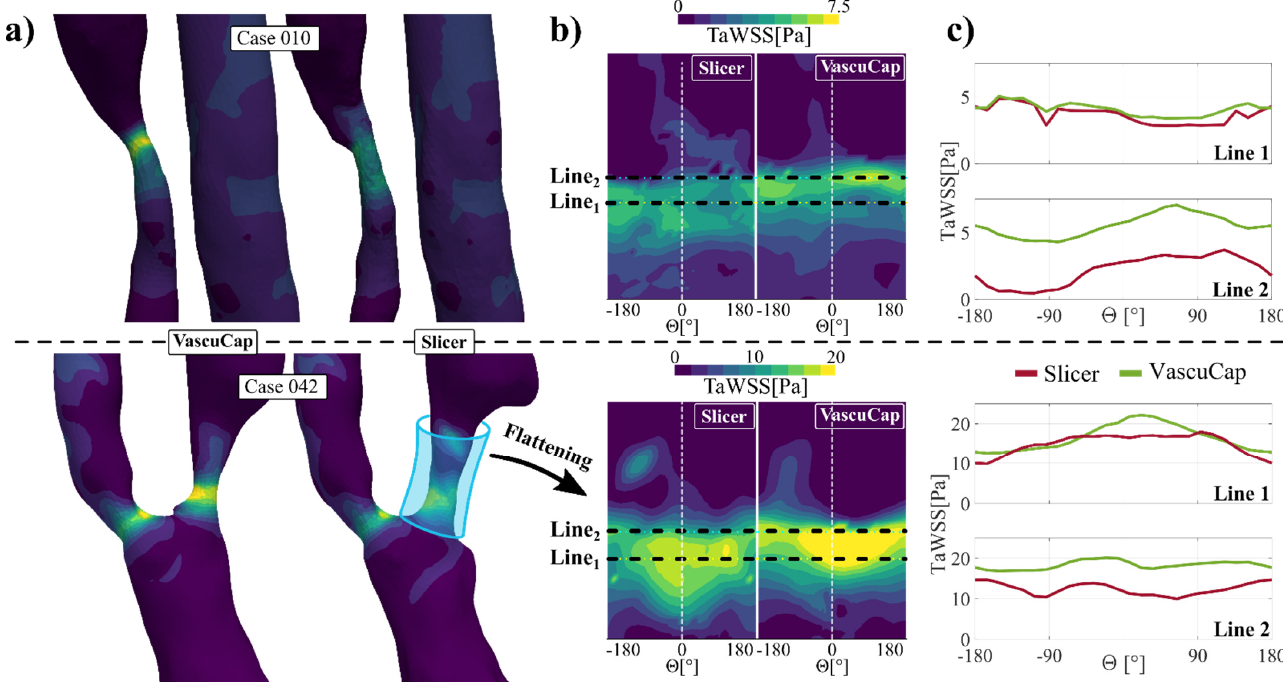
Figure 6. Results of the CFD simulations for Case 010 and Case 042. ( a ) Time-averaged WSS field near the stenosed vessel segment visualized on the vessel wall. ( b ) Flattened TaWSS maps near the stenosis for easier comparison. ( c ) circumferential TaWSS values at different altitudes (Line 1,2 ) from the bifurcation point; WSS: wall shear stress TaWSS: Time-averaged WSS. CFD: Computational fluid dynamics.